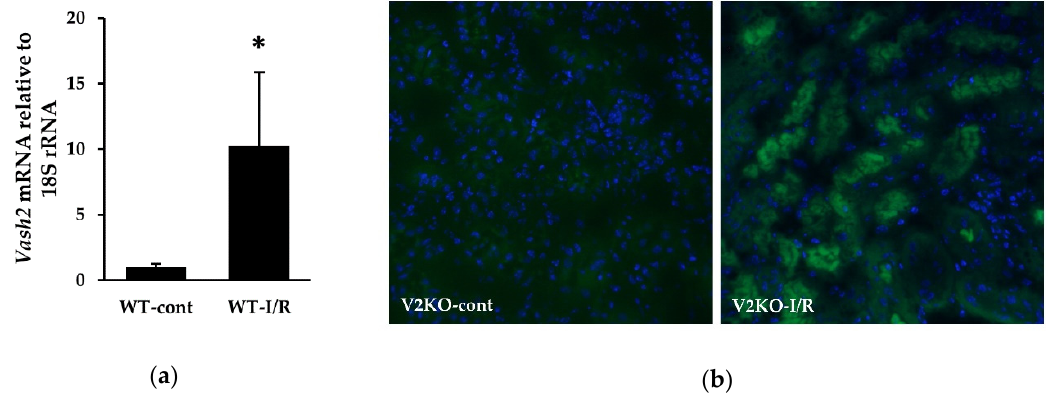
Figure 5. Endogenous VASH2 expression in the kidney in response to I/R injury. ( a ) Vash2 mRNA levels determined by real-time PCR in the kidneys from WT-cont and WT-I/R mice. n = 6 for each group. Data were normalized with the expression of 18S rRNA. ( b ) Immunofluorescence staining for β -galactosidase ( β -gal) to detect β -gal expression in the kidneys from V2KO-cont (left) and V2KO-I/R (right) mice. For nuclear staining, 4 ′ ,6-diamidino-2- phenylindole (DAPI) was used (original magnification, × 200). * p < 0.01 vs. WT-cont. The column shows the mean ± SD.